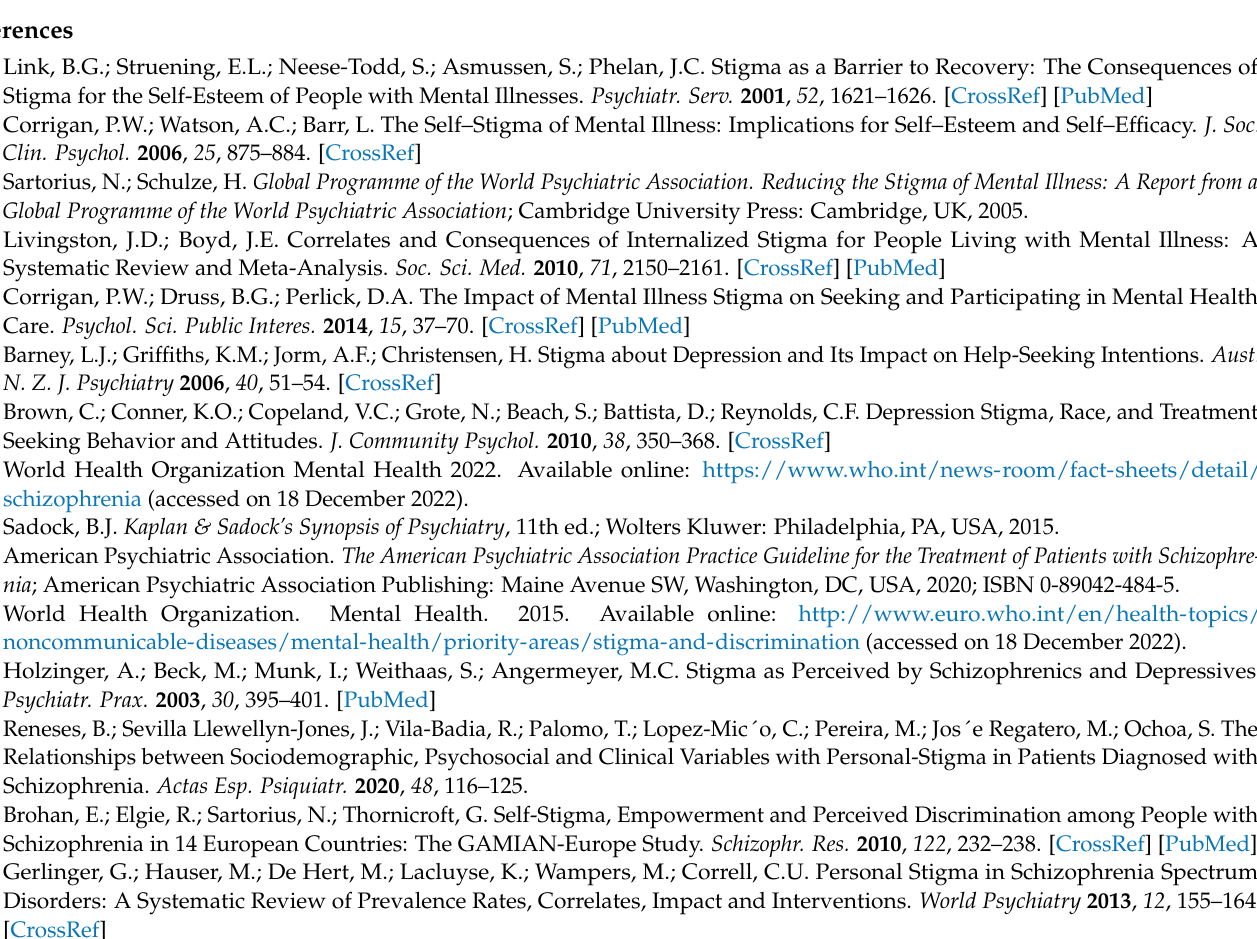
Table S2: Summary of the NHRMC Evidence Statement